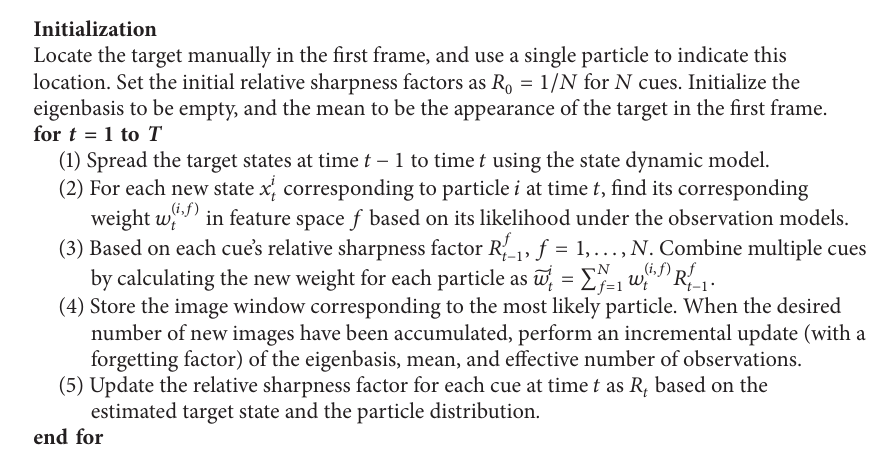
Algorithm 1: Multicue based IVT